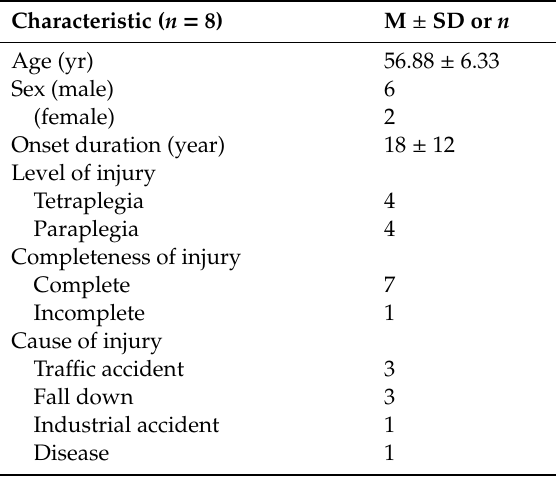
Table 1. General characteristics of participants.